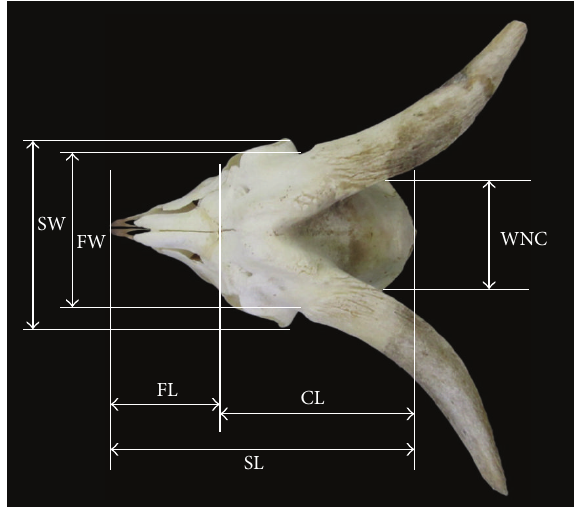
Figure 1: Dorsal view of the skull of Markhoz goat showing SL: skull length, FL: facial length, CL: cranial length, SW: skull width, FW: facial width, and WNC: width of neurocranium.